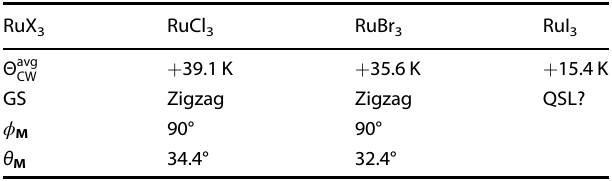
Fig. 5 Ab-initio computed pseudospin models across the RuX 3 family. a Quantum chemistry results for local gyromagnetic g -tensor components g ∥ (in-plane) and g ⊥ (out-of-plane). b – d projED results for the magnetic exchange couplings on nearest-neighbor (NN), second- neighbor (2NN), and third-neighbor (3NN) bonds. Tabular form of all values is given in the Supplementary Information. Table 2. Properties of derived pseudospin